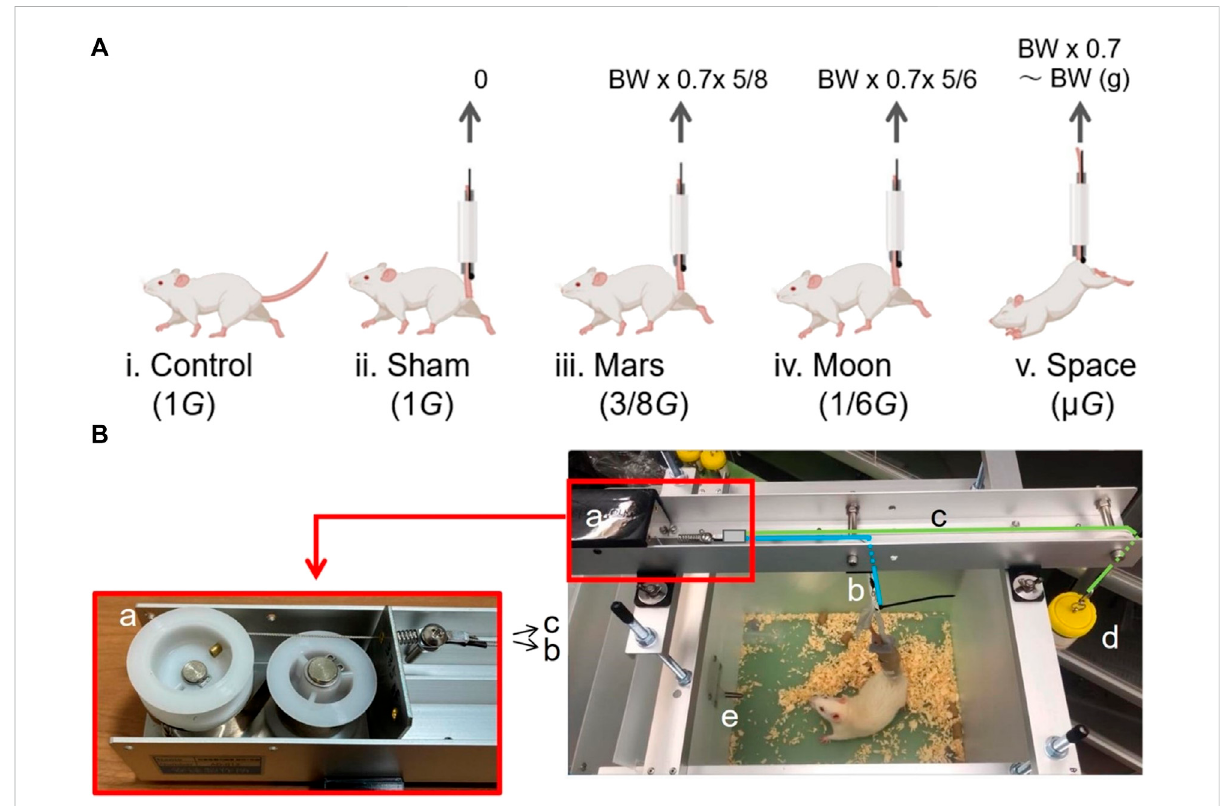
FIGURE 1 The groupsofexperimentalrats (A) andthecore components ofthenewtypeof simulated partial gravityapparatus (B) .Control group(1 G ) (Ai) ; sham group with SA (1 G ) (Aii) ; Mars group (3/8 G ) (Aiii) ; Moon group (1/6 G ) (Aiv) ; and interplanetary space (µ G ) group (Av) . Black spring storage box with two built-in pulleys and a spring wire splitter (Ba) ; spring wire connected to the rat ’ s tail (Bb) ; spring wire connected to the balance container (Bc) ; balance container (Bd) ; and partition (Be)